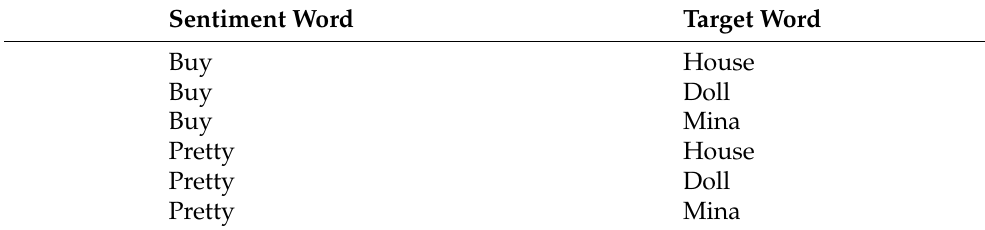
Figure 1. Diagram of the analysis sentence, “Mina buy a pretty doll house”. Table 4. Extractable sentiment-target word